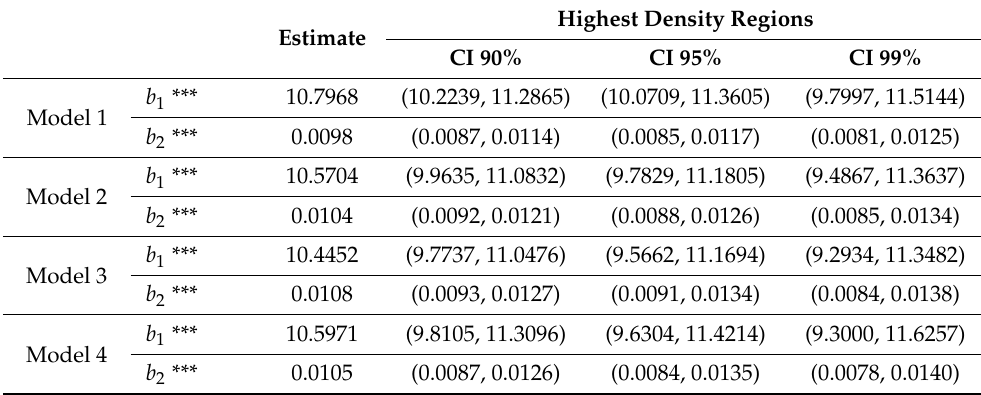
Table 3. Results for Model 1 to Model 4 (data from 1990 to 2019).